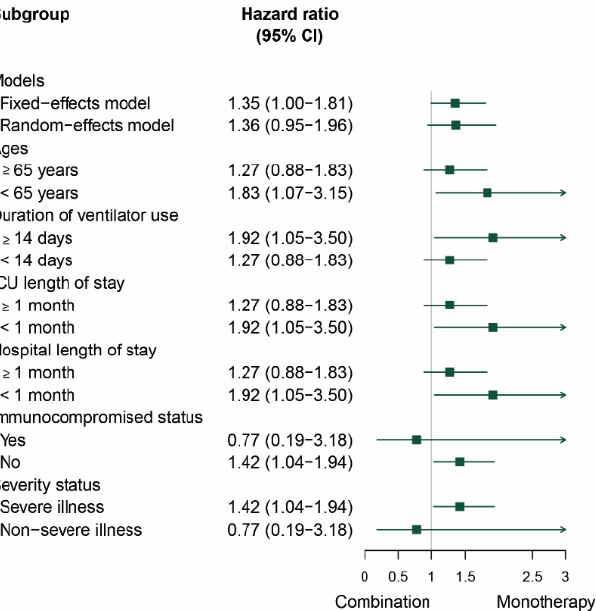
Figure 3. Forest plot presenting the HRs of subgroup analysis of patients with S. maltophilia infections compared between combination therapy and monotherapy.